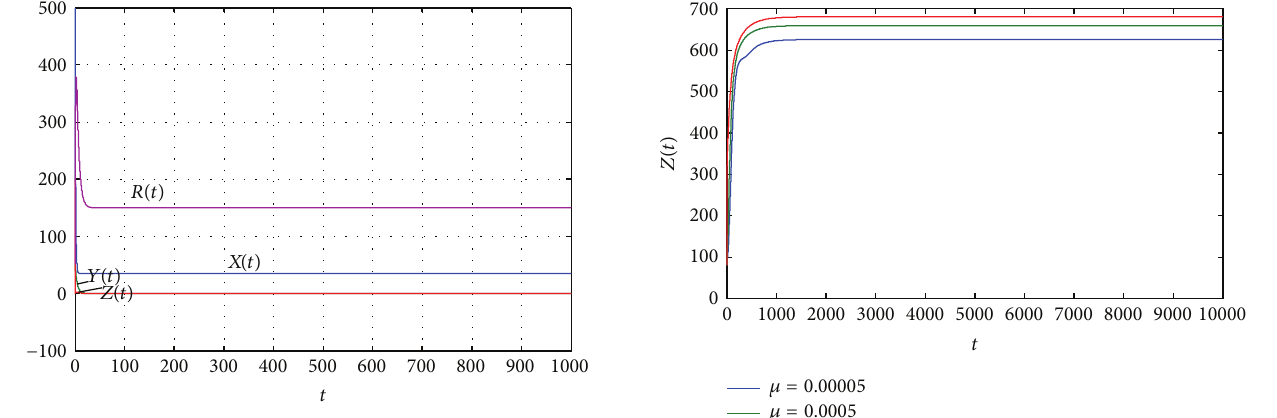
Figure 2: When 𝜀 = 3 , 𝑘 1 = 0.0005 , 𝑘 2 = 0.0002 , 𝑘 3 = 0.04 , 𝛽 = = 0.2 , 𝜇 = 0.00005 , 𝜎 = 0.85 , 𝛼 = 0.25 , 𝜃 = 0.001 , 0.0005 , 𝑘 4 = 0.2725 < 1 . 𝜆 = 0.06 , and 𝑅 0